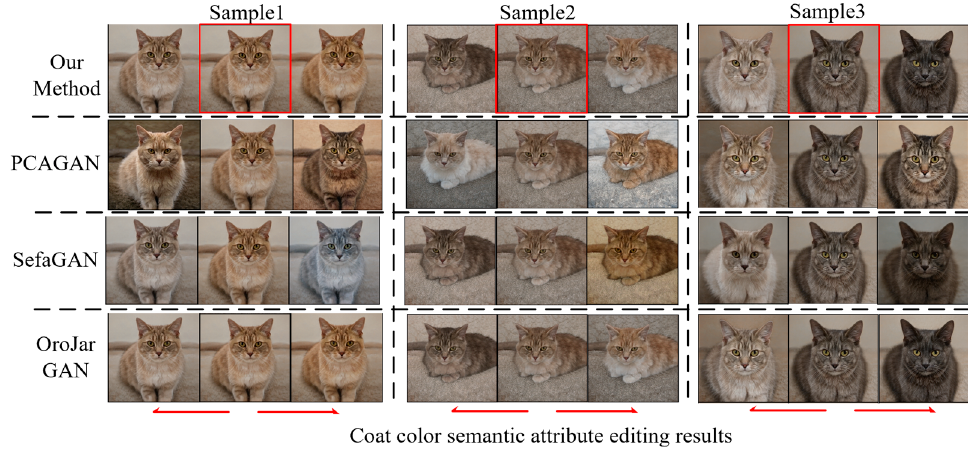
Figure 12. LSUNCat dataset rotates semantic attribute editing comparison results.